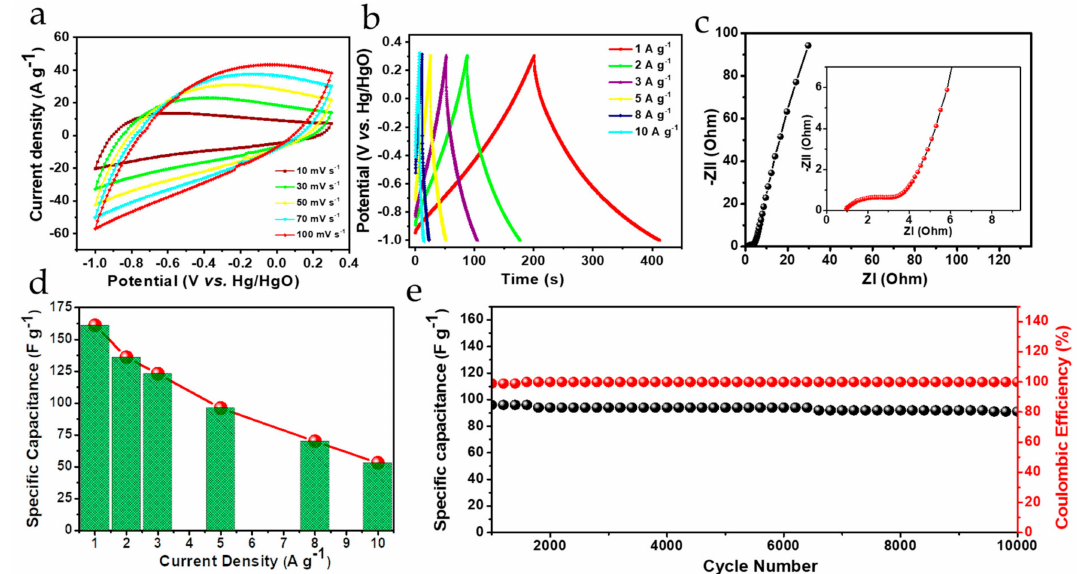
Figure 5. ( a ) CV, ( b ) GCD, ( c ) electrochemical impedance spectroscopy (EIS), ( d ) rate capability, and ( e ) cycling test results from the Bi 2 O 3 -MnO 2 ES